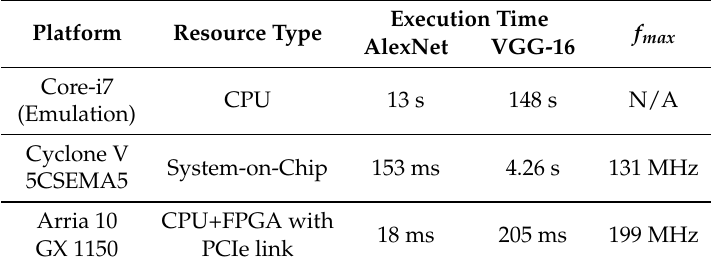
Table 1. Execution times for Alexnet and VGG (batch size = 1).